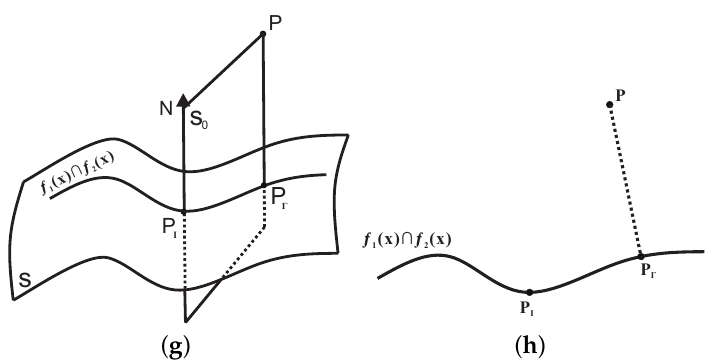
Figure 5. Graphic interpretation of the whole iteration process in Algorithm 3. ( a ) Newton’s steepest gradient descent method in the first step; ( b ) Computing the foot-point Q in the second step; ( c ) Newton’s steepest gradient descent method in the third step; ( d ) Moving the iteration point P I to the position close to the orthogonal projection point P Γ through joint implementation of the second and third steps 5 times; ( e ) The Newton’s steepest gradient descent method of the first two formulas in formula (19) of Algorithm 3; ( f ) The Newton’s steepest gradient descent method related to the test point of the third formula in formula (19) of Algorithm 3; ( g ) Accelerating and correcting method of the fourth formula in formula (19) of Algorithm 3; ( h ) The iterative point P I finally iterates to the orthogonal projection point P Γ